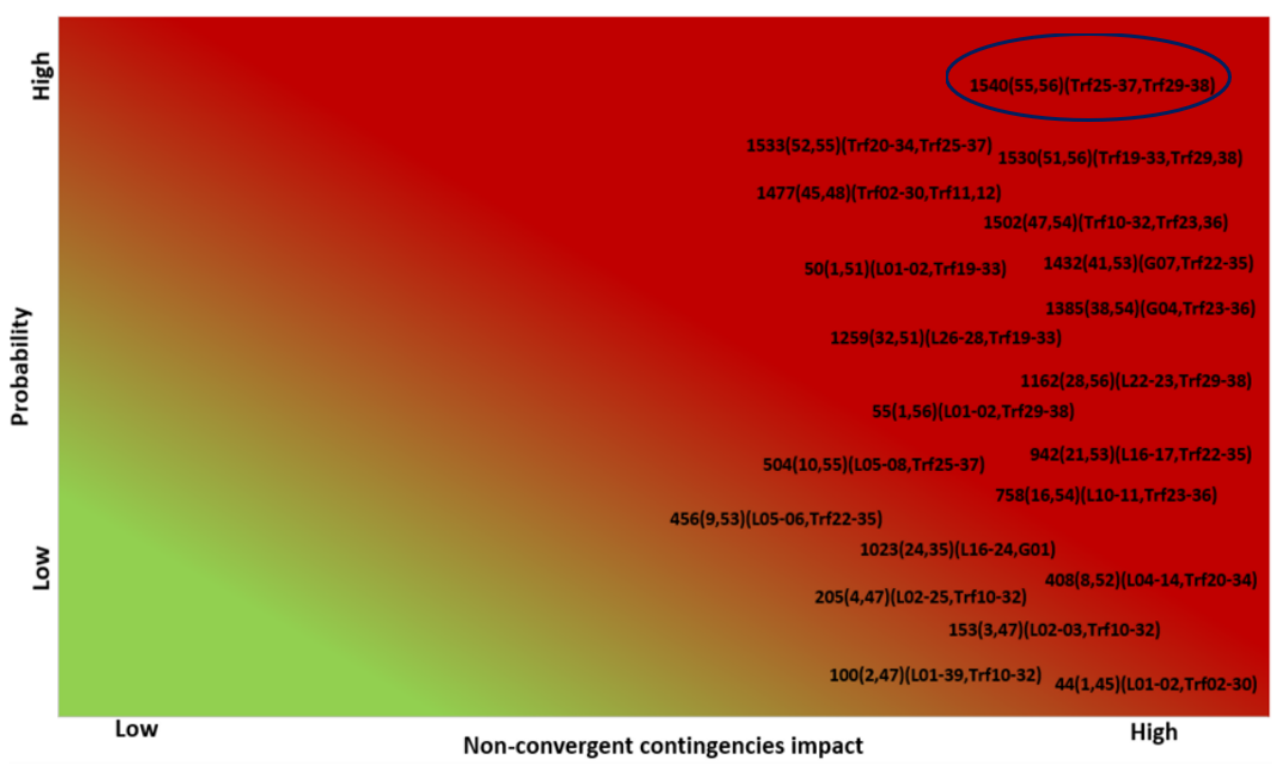
Figure 10. Risk–based system collapse contingencies chart. For example, contingency number 1540 (indicated) in which component number 55 (Trf 25–37) and component number 56 (Trf 29–38) fall in the HIHP region.